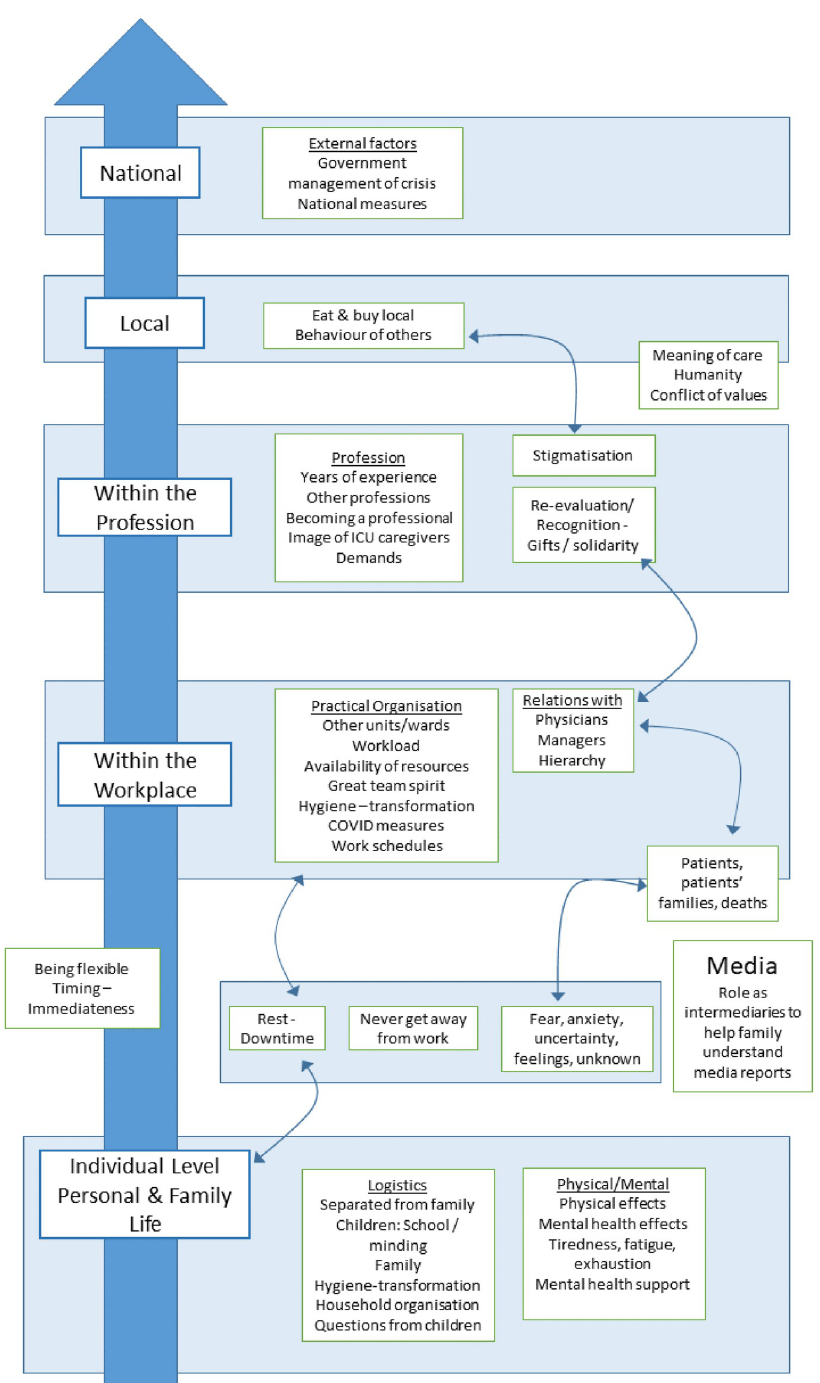
Fig 1. Conceptual framework describing the main themes and the relations between them.